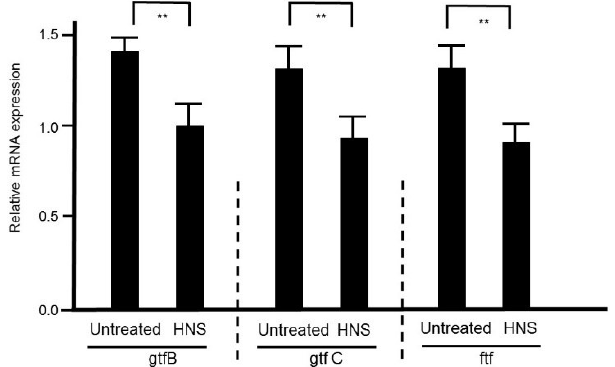
Figure 7. Inhibitory effects of the HNS on the mRNA expression of β‐ glucosyltransferase (gtfB), glucosyltransferase-SI (gtfC), and fructosyltransferase (ftf) in S. mutans . S. mutans cells were treated with HNS (500 µ g / mL) for 12 h or left untreated, and the total RNA was extracted. The relative mRNA values of gtfB , gtfC , and ftf were measured using a RT-PCR system normalized using 16S rRNA as the housekeeping gene. Data represent mean ± S.D. ( n = 6). **: p < 0.01 by Student’s t ‐test.